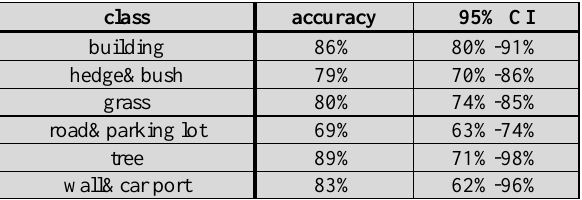
Table 4. Producer’s accuracy of the derived land cover map by